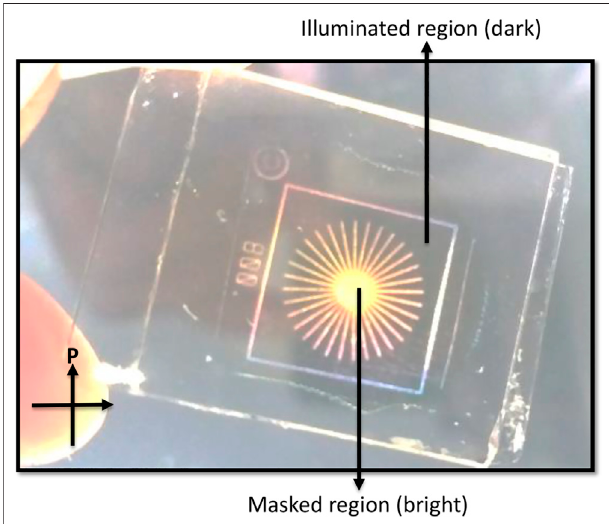
FIGURE 9 | Optical storage device showing good contrast between dark and bright states using the guest-host effect under the crossed polarizers. Here compound E12 acts as a guest and NLC acts as a host molecule. Intensity of the light used is 5 mW/cm 2 and illuminated for 10